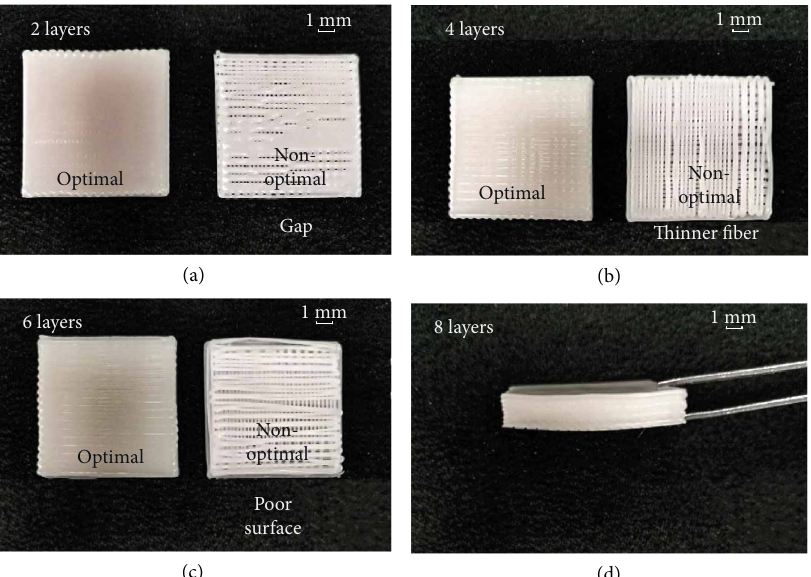
Figure 6: Cuboids with different combinations of parameters. The optimal parameter was 𝐴